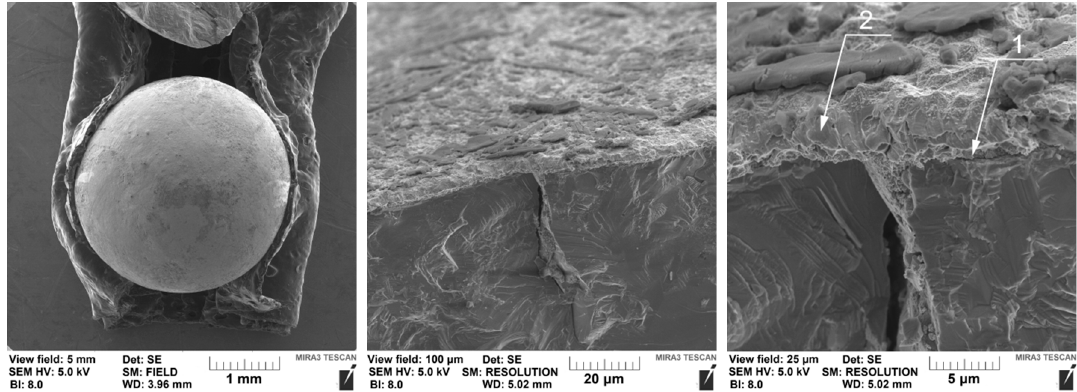
Figure 12. Micrographs of a multilayer coating on the surface of a titanium hydride shot: 1—chemisorption layer, 2—copper layer.